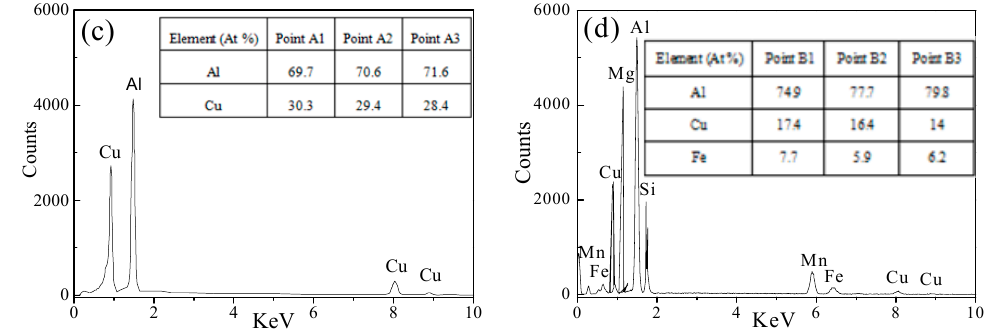
Figure 4. Microstructures and energy dispersive spectroscopy (EDS) results of the as-cast 2219 aluminum alloy: ( a ) Optical microstructure; ( b ) SEM microstructure; ( c ) EDS results for point A; ( d ) EDS results for point B.